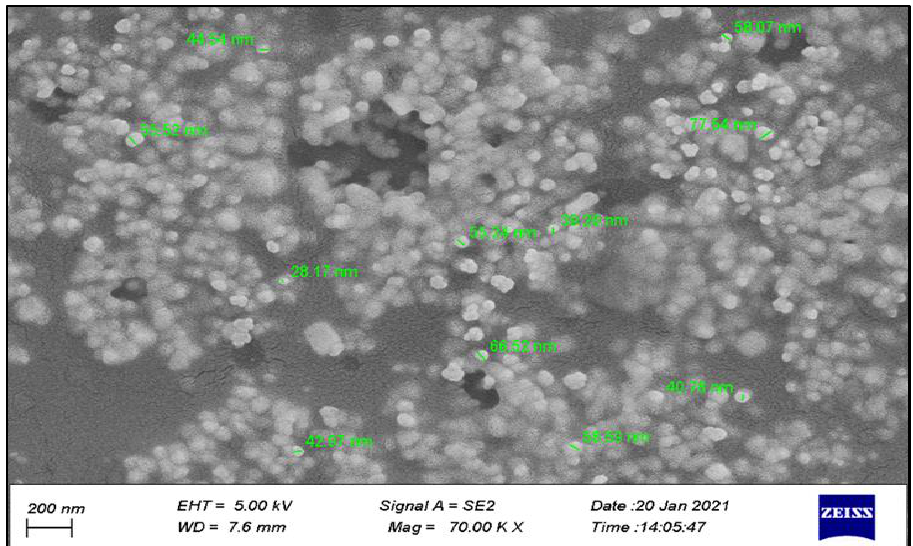
Figure 1: SEM images of ZnO/epoxy nanocomposite with 2 wt. % content of